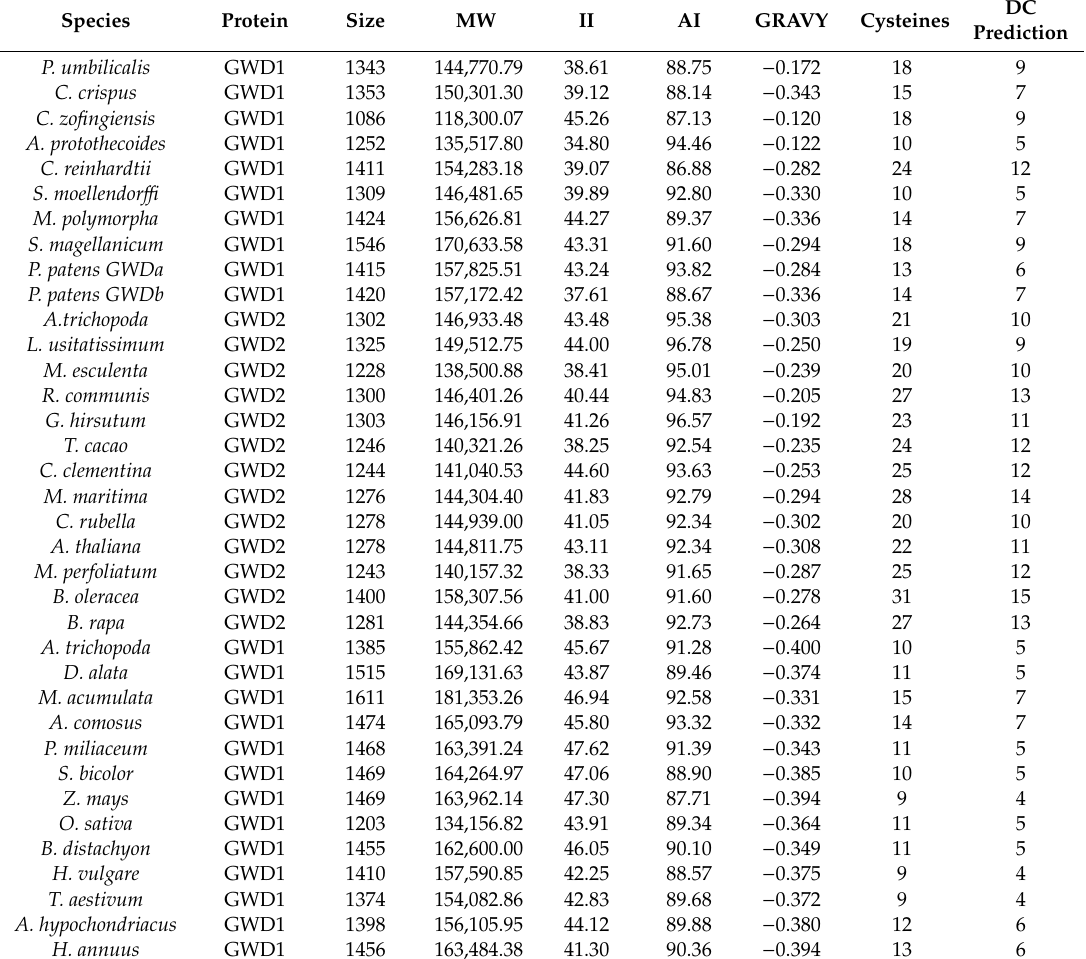
Table 1. Physio–chemical properties of the GWD protein in selected plant